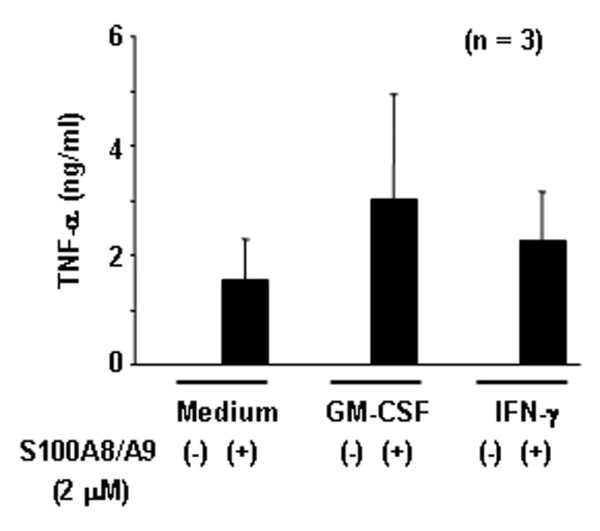
Induction of tumor necrosis factor alpha (TNF-α) production by in vitro-differentiated macrophages after S100A8/A9 stimulation. Monocytes (1 × 106 cells per ml in culture medium with 10% fetal calf serum) were incubated for 7 days with or without 10 ng/ml granulocyte-macrophage colony-stimulating factor (GM-CSF) or 1 ng/ml interferon gamma (IFN-γ). The in vitro-differentiated macrophages were then stimulated for 24 hours with 2 μM S100A8/A9 in the presence of polymyxin B (100 μg/ml). Culture supernatants were measured for TNF-α concentrations by enzyme-linked immunosorbent assay. Values are the mean ± standard error of the mean. n, number of samples tested.